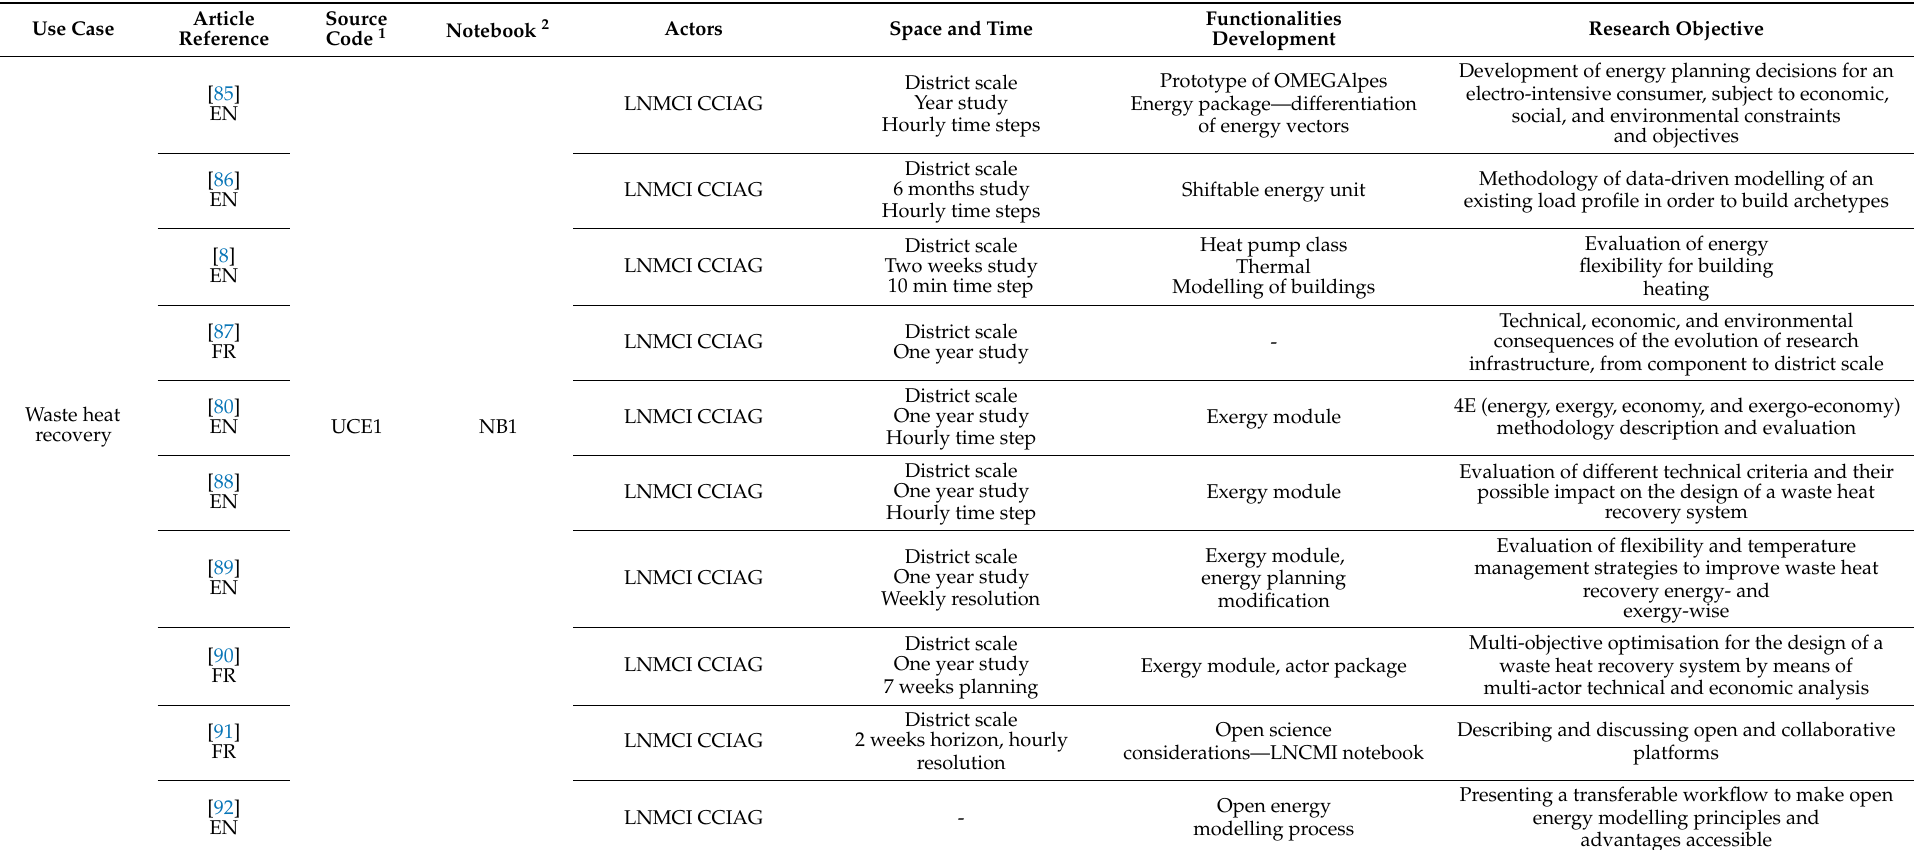
Table 6. OMEGAlpes use cases library including article references and languages, source code, notebooks, space and time scale and resolution, developments, and research